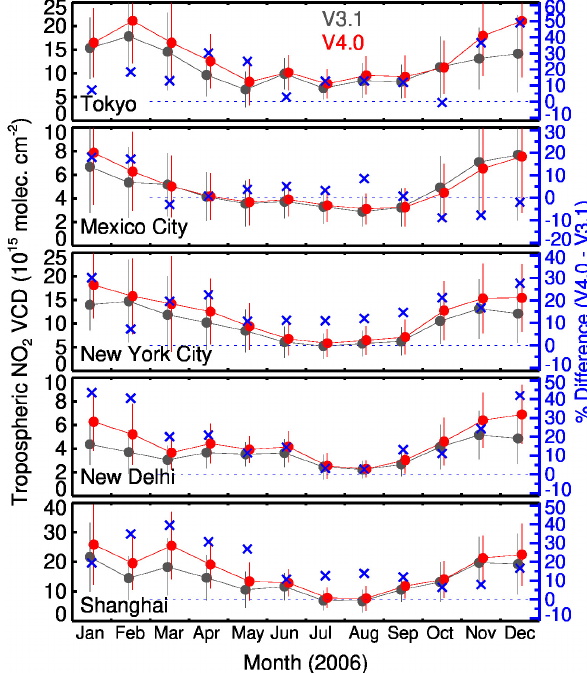
Figure 12. Same as Fig. 11, but for a 1 ◦ latitude × 1 ◦ longitude box over five highly populated and polluted cities.